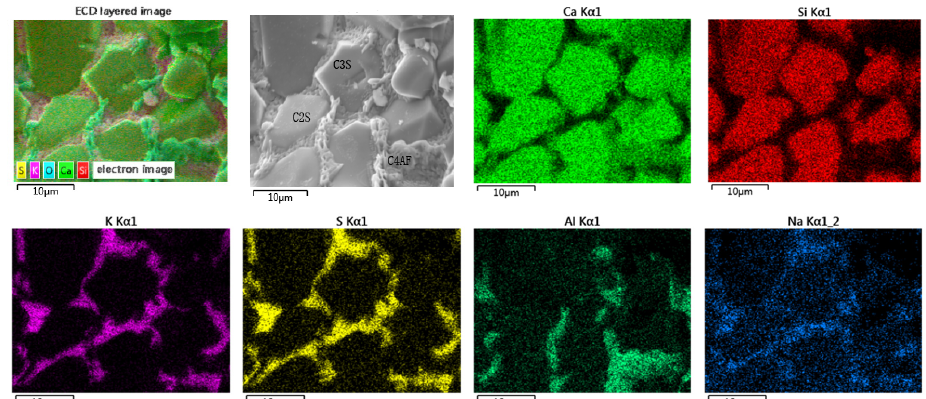
Figure 3. The SEM map scanning images of Portland road cement (×1000).